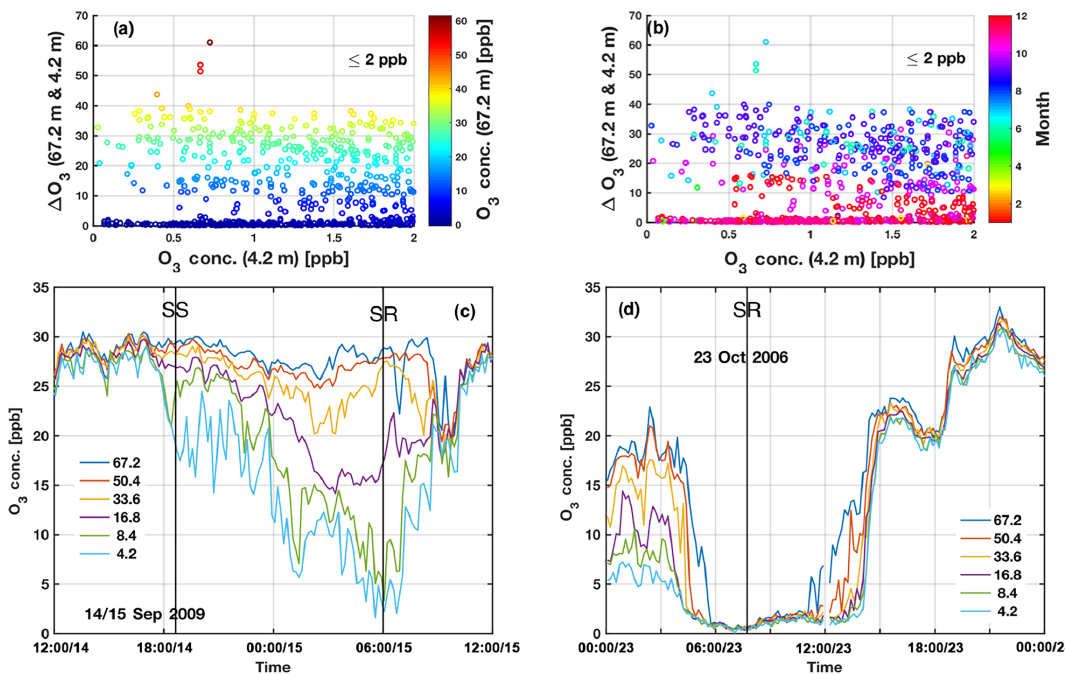
Figure 9. The ozone concentration difference between 67.2 and 4.2m vs. the ozone concentration ( ≤ 2ppb) at 4.2m, (a) colour-coded by ozone concentrations at 67.2m and (b) colour-coded by month. (c) A near-surface depletion event on 14–15 September, 2009. (d) A full-profile depletion event on 23 October 2006. The vertical black lines indicate the sunrise (SR) and sunset (SS) times. Table 2. The number of full-profile and near-surface ozone depletion events that last for more than 3h. Since the two highest measurement levels (101 and 125m) were introduced in February 2013 only, the statistics for the full-profile depletion events shown here are based on measurements at 67.2m and lower heights. The statistics were based on the original 10min data. Statistics based on gap-filled data are presented in